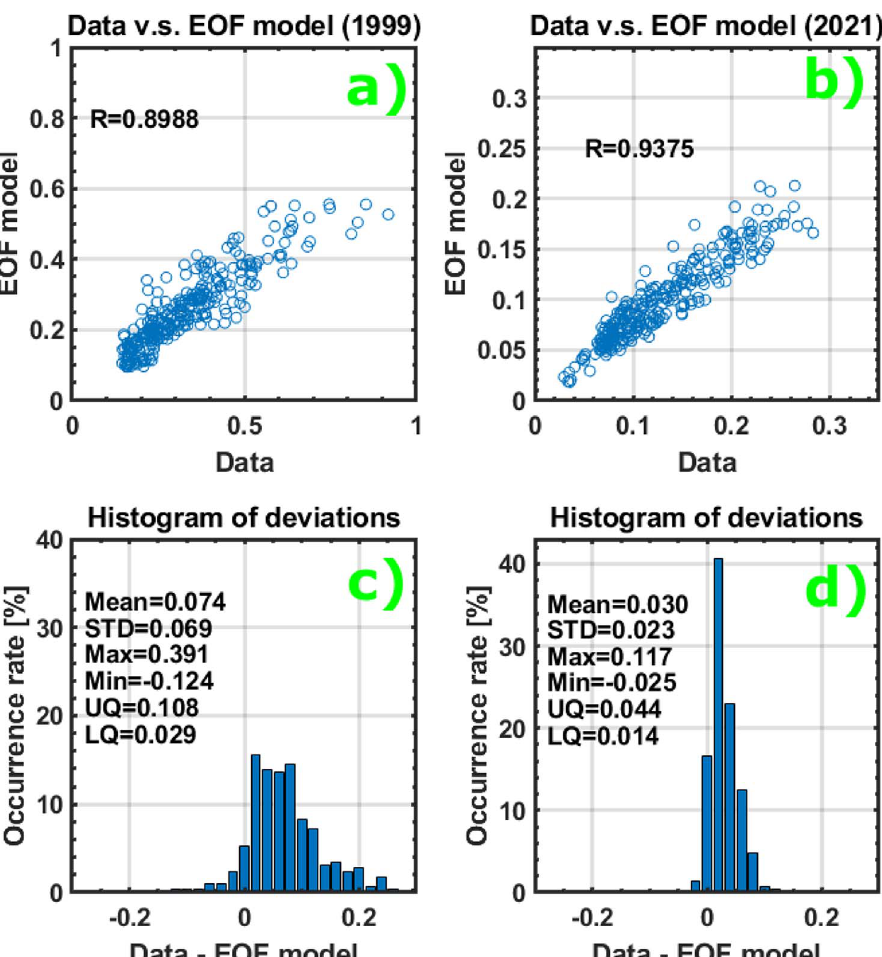
Fig. 9. (a – b) The comparison of reconstructed ROTI using the EOF model versus the experimental ROTI data. (c – d) The histogram of the bias (Data – Model) using a bin step of 0.02 TECU/min. UQ = upper quartile; LQ = lower